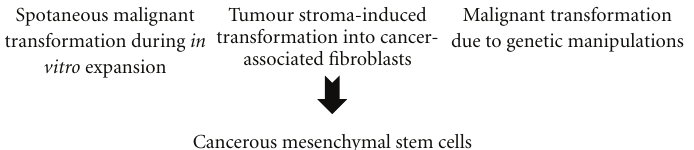
Figure 2: Direct involvement of mesenchymal stem cells in cancer through malignant